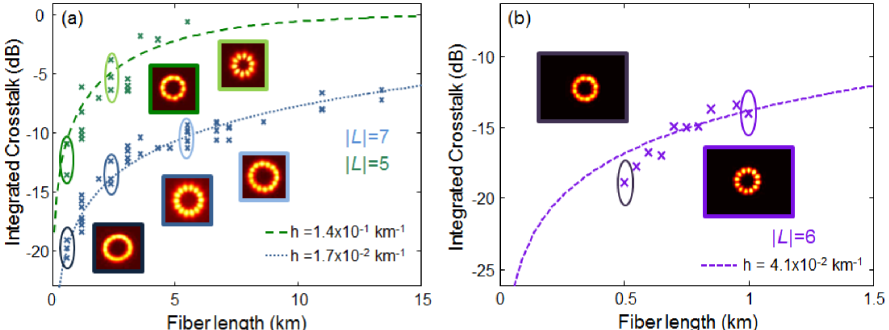
Figure 7. ( a ) Measured crosstalks for | L | = 5 and | L | = 7 modes in an AH-RCF (stars), and theoretical crosstalks which have the minimum mean-squared error from the measured data (dashed lines). ( b ) Measured and theoretical crosstalks for | L | = 6 modes. Insets are modal images at the output of fiber with different length. Reprinted with permission from Ref. [36] © The Optical